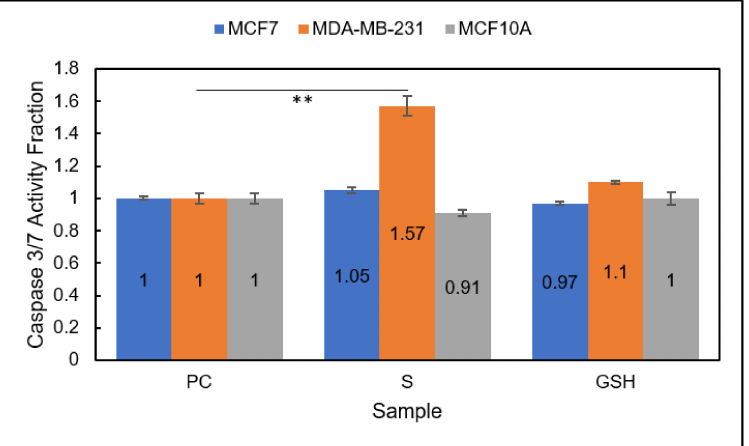
Figure 11. Caspase 3/7 activity fraction of MCF7 (blue), MDA-MB-231 (orange), and MCF10A (gray) cells detected using the Caspase-Glo 3/7 Assay. Sample groups include: untreated PC cells, S (Group 2) and GSH-treated cells. Data points represent the mean ± standard deviation. Statistically different values from the control are indicated by ** p <